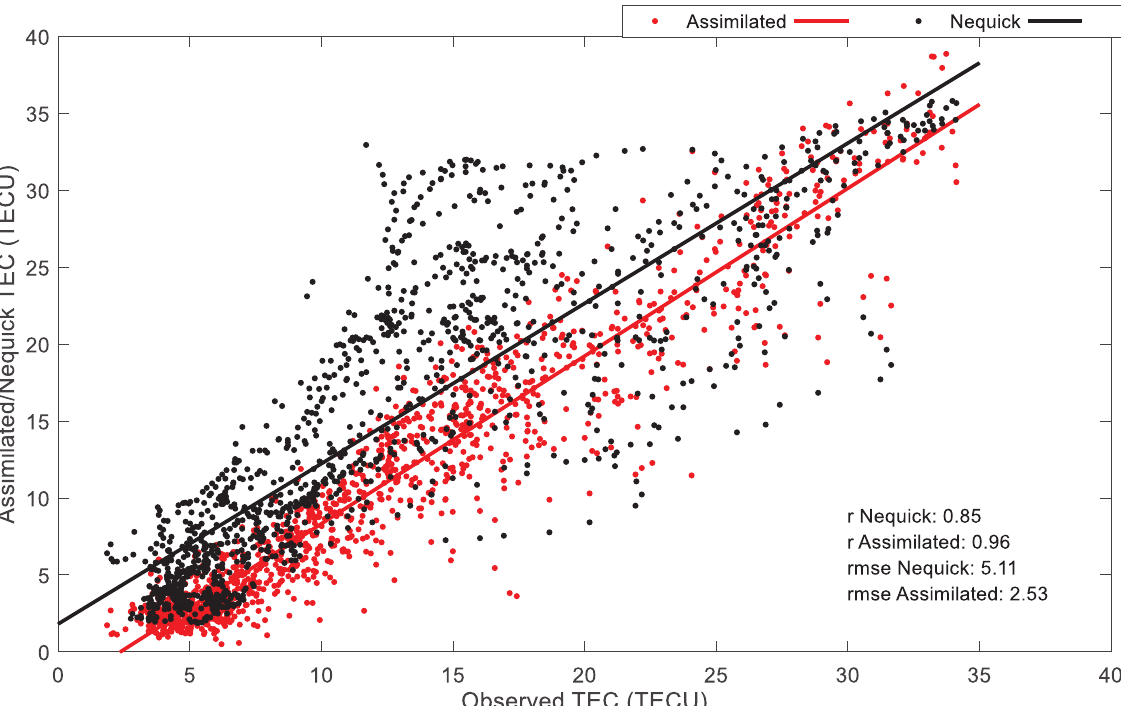
Figure 8. Scatter plot of TEC obtained from NeQuick model (red color) and assimilation result (black color) as a function of coincident observed TEC over GPS receiver station at YONS. The data plotted are the same as that in Figure 7.